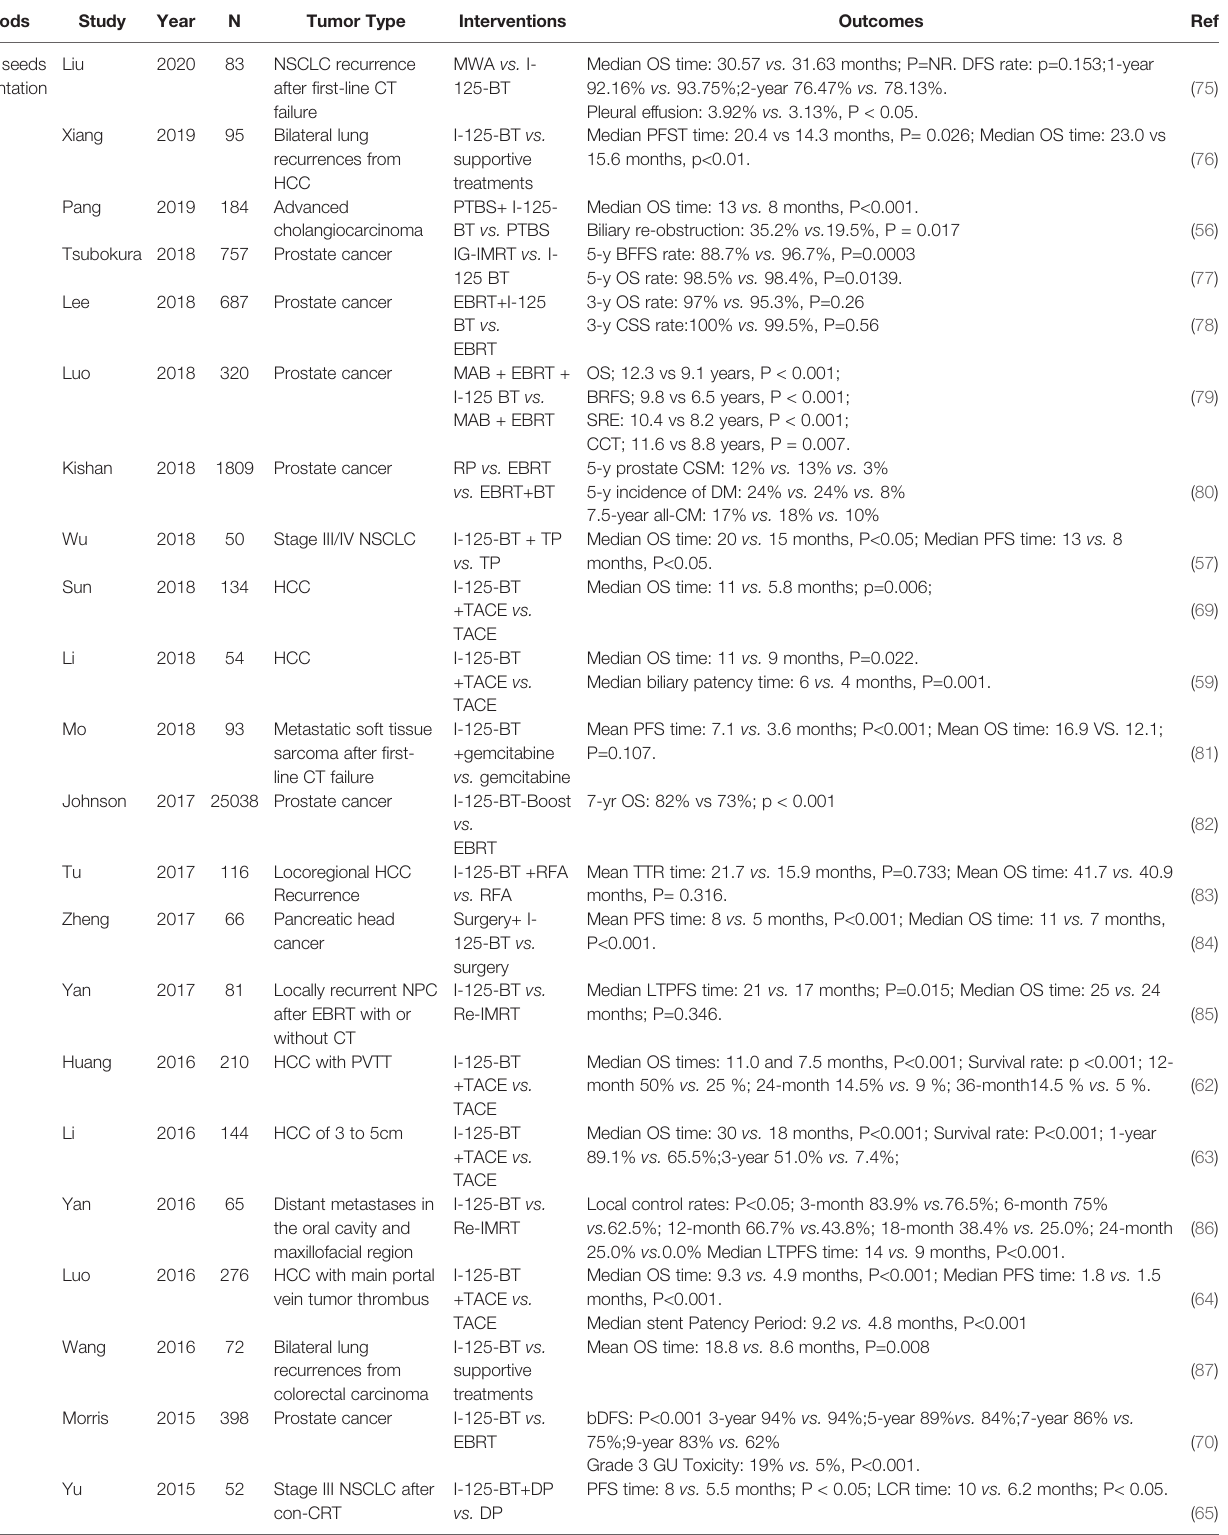
TABLE 3 | The key controlled clinical trials of I-125 seeds therapy in the past decade.